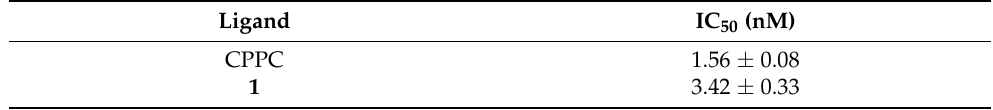
Table 1. IC 50 values of CPPC and 1 for CSF1R.